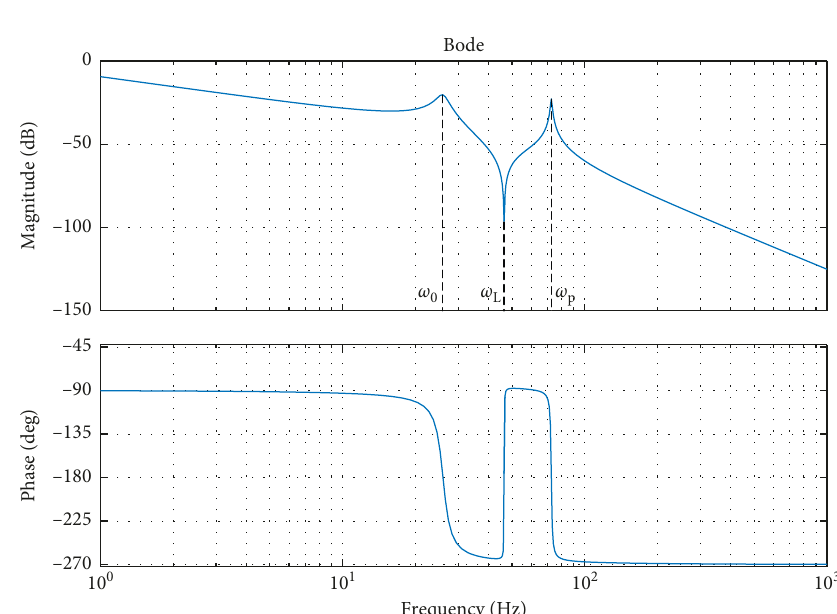
Figure 6: The Bode diagram of the open-loop transfer function under the elastic